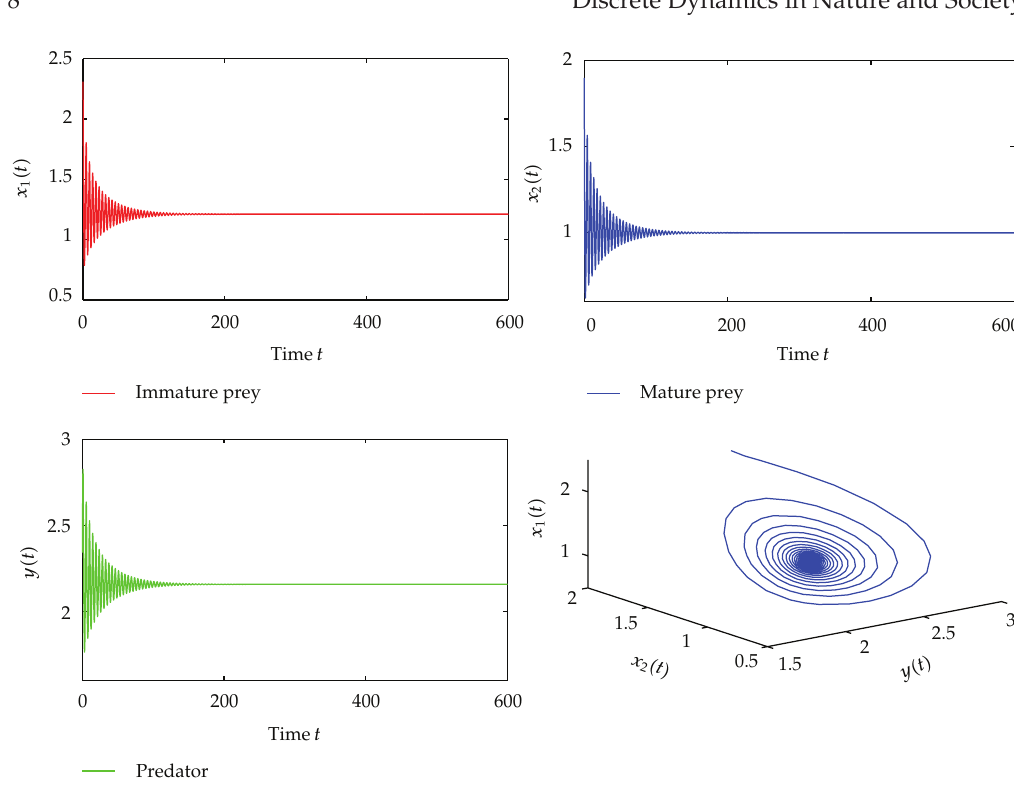
Figure 1: E 0 is locally asymptotically stable for τ 1 (cid:6) 0 . 8500 < τ 10 (cid:6) 0 . 9032 with initial value “2.31; 1.9;